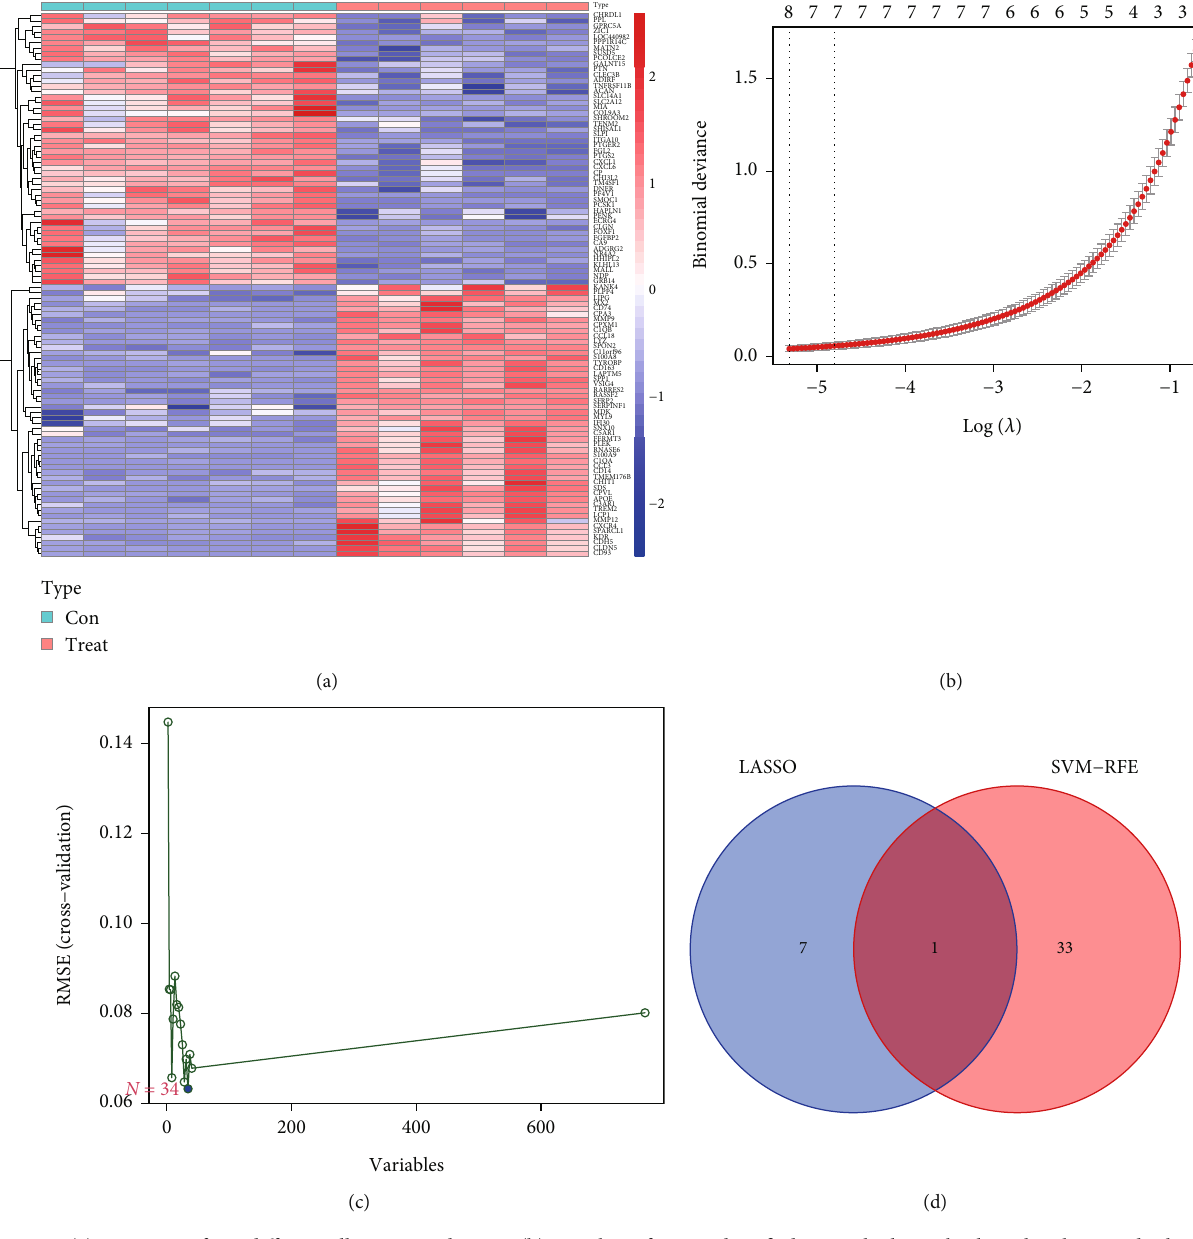
Figure 2: (a) Heatmap of top di ff erentially expressed genes. (b) Number of genes identi fi ed using the least absolute shrinkage and selection operator (LASSO) regression method. (c) Number of genes detected using the support vector machine (SVM) regression method. (d) A Venn plot of overlapping genes obtained from LASSO and